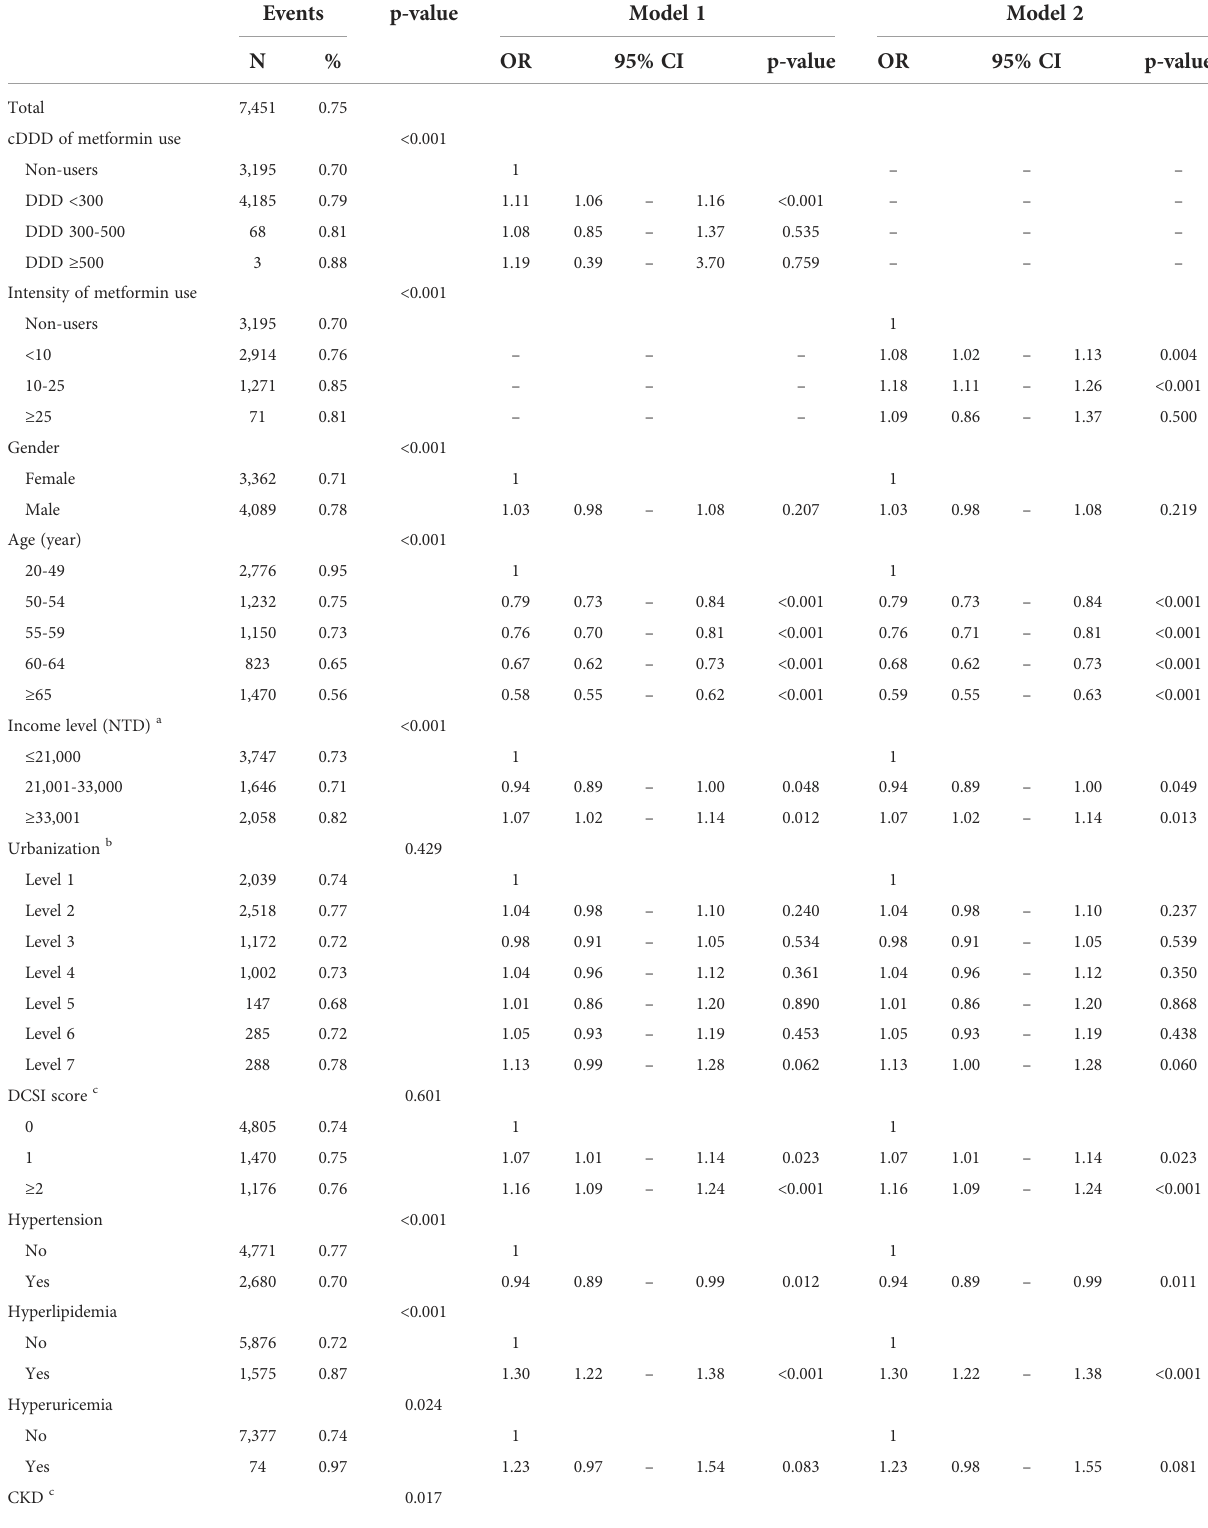
TABLE 2 Three-year follow-up of incident non-alcoholic fatty liver disease in new-onset diabetes mellitus patients with metformin